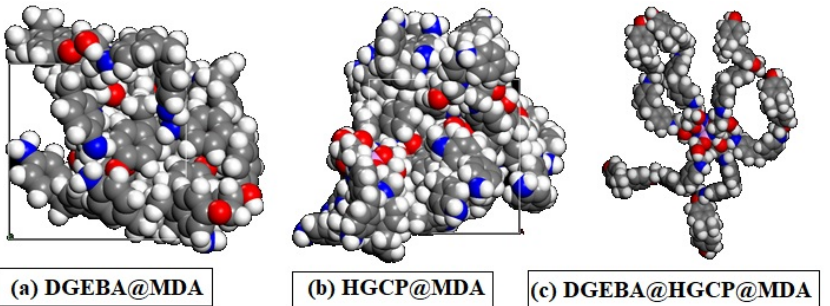
Figure 5. Schematic description of modeling system of ( a ) DGEBA@MDA, ( b ) HGCP@MDA, and ( c )